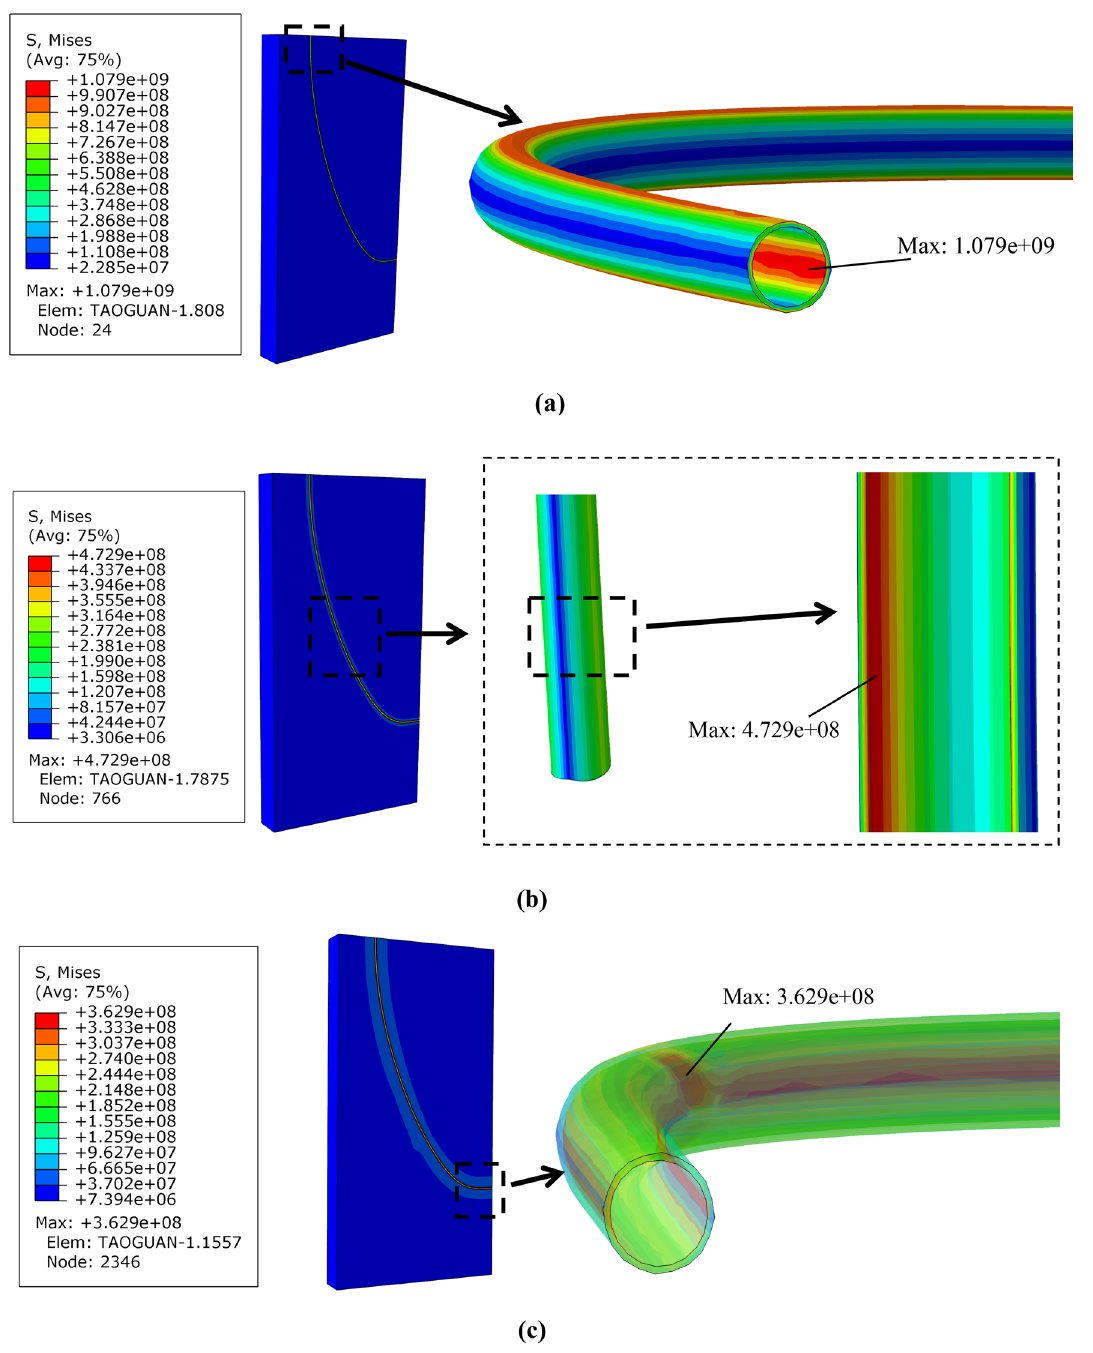
Fig. 15 Stress cloud map of casing under different Young’s modulus of elasticity of rock. a Young’s modulus of elasticity of rock, 5 GPa. b Young’s modulus of elasticity of rock, 45 GPa. c Young’s modulus of elasticity of rock, 85